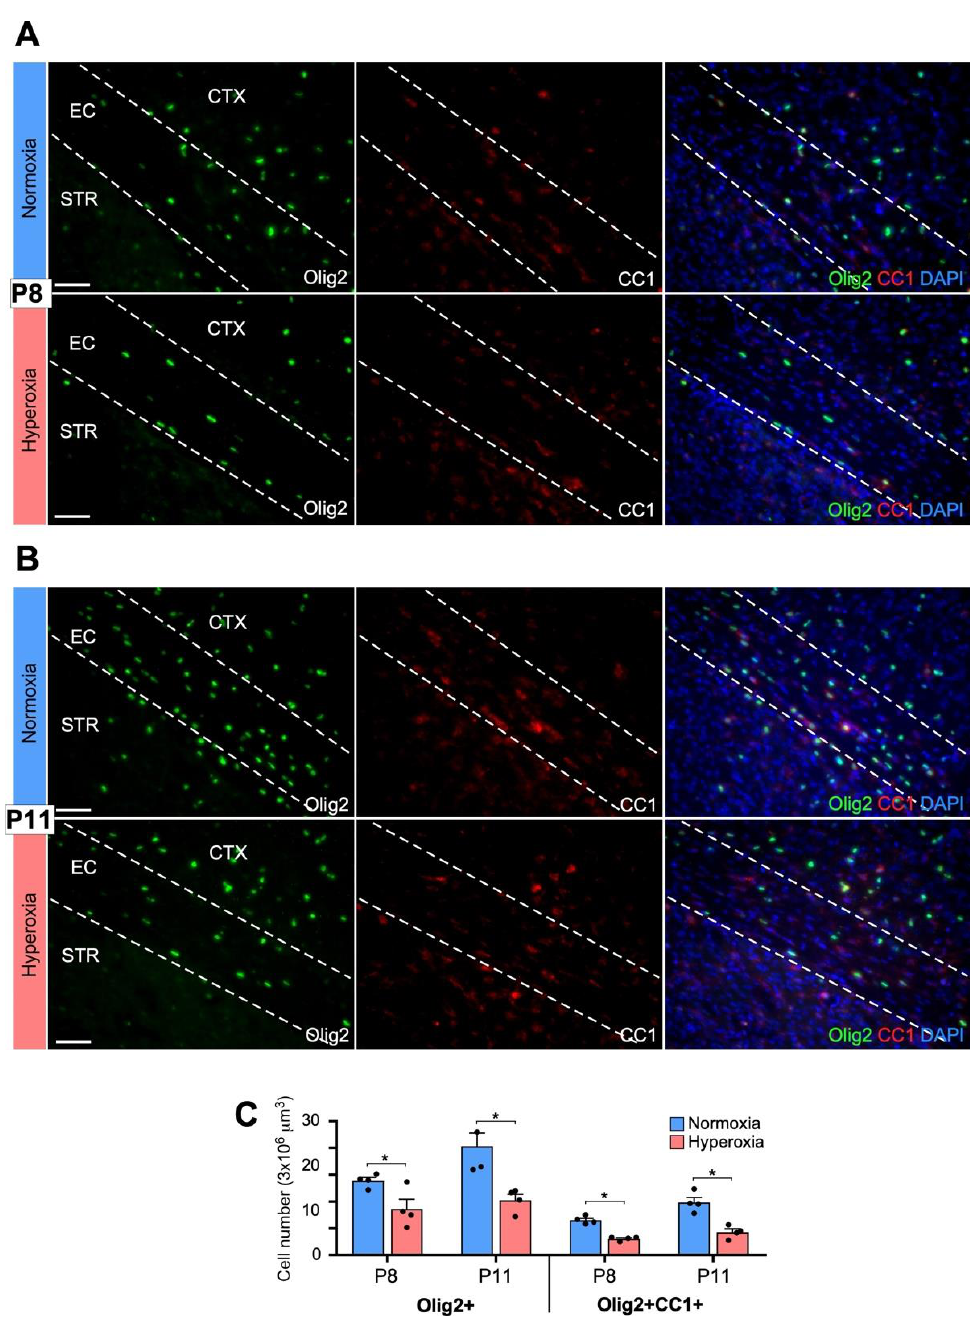
Figure 3. Hyperoxia exposure results in reduction of Olig2+ and CC1+ oligodendrocytes within immature white matter. EC, external capsule; CTX, cortex; STR, striatum. Olig2, marker of all oligodendrocytes, CC1, marker of mature oligodendrocytes. Dashed lines depict the margins of the EC. ( A ) Fluorescent images at P8 (20×) showing reduction in the number of Olig2+ (green) and Olig2+CC1+ (green and red) oligodendrocytes in hyperoxia vs. normoxia. Scale bar = 50 μ m. ( B ) The reduction of oligodendrocytes at P8 is sustained at P11 within the EC, marked by dashed white lines. Scale bar = 50 μ m. ( C ) Quantification of Olig2+ and Olig2+CC1+ cells within the EC at P8 and P11 in normoxia and hyperoxia. Data shown as mean ± SEM for each group (n = 4 – 6 animals, 5 images/animal), using an unpaired two-tailed t test comparing normoxia vs. hyperoxia; * p < 0.05. Using non-parametric Mann – Whitney analyses, ( C ) (Olig+2 at P8), is not statistically significant.